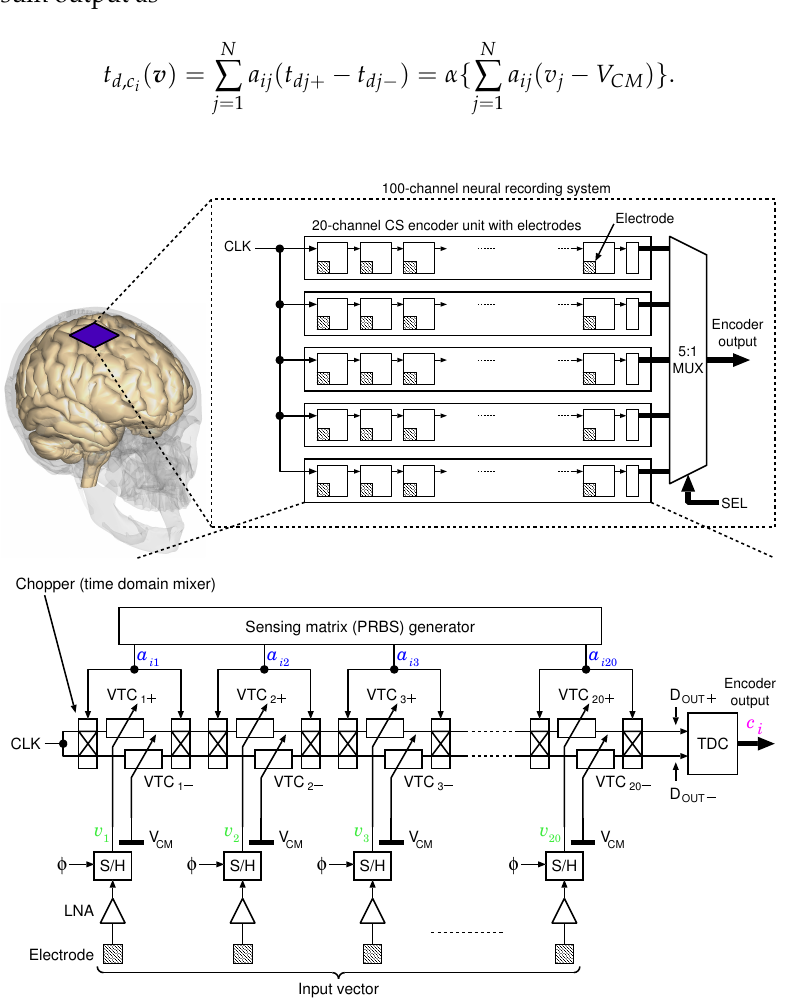
Figure 4. Block diagram of the proposed 100-channel time domain analog spatial CS encoder